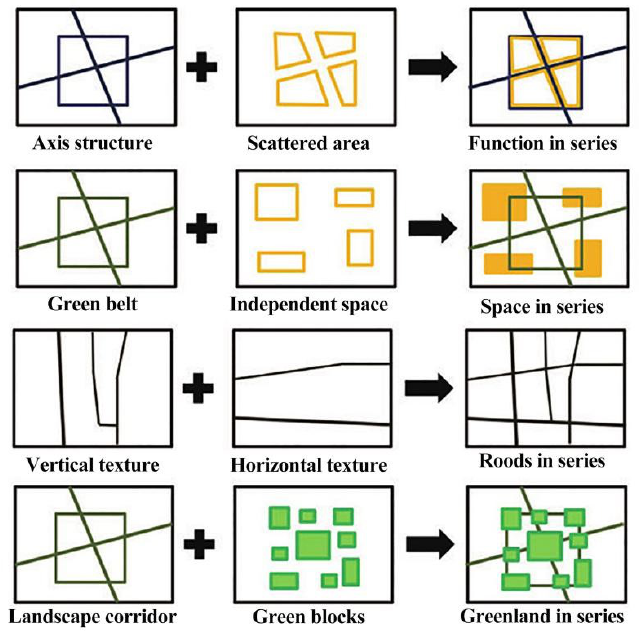
Fig. 2 Network model of small towns in ecological